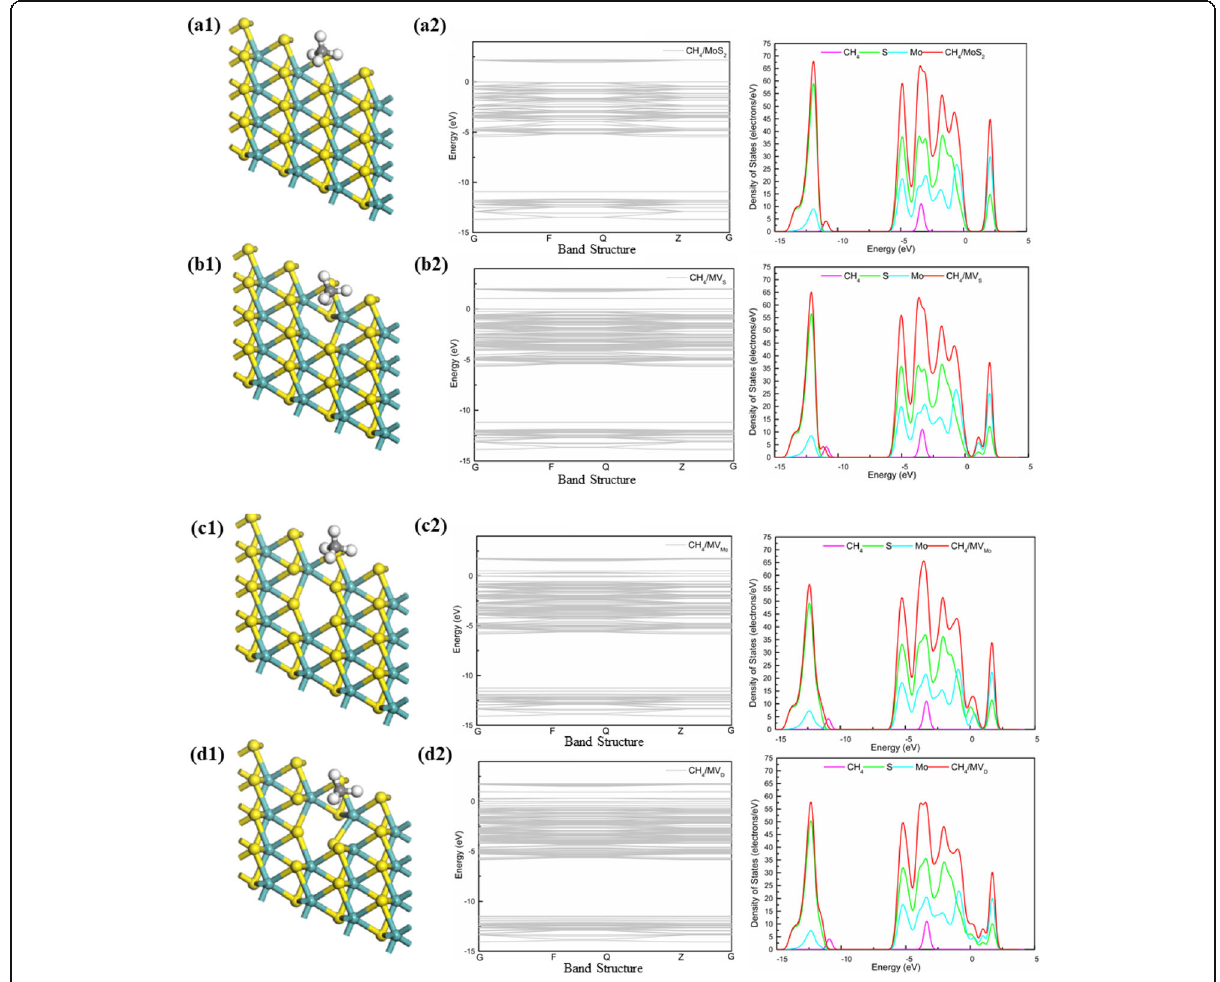
Fig. 4 The structure and DOS of CH 4 gas molecule on four systems (MoS 2 , MV S , MV Mo , and MV D